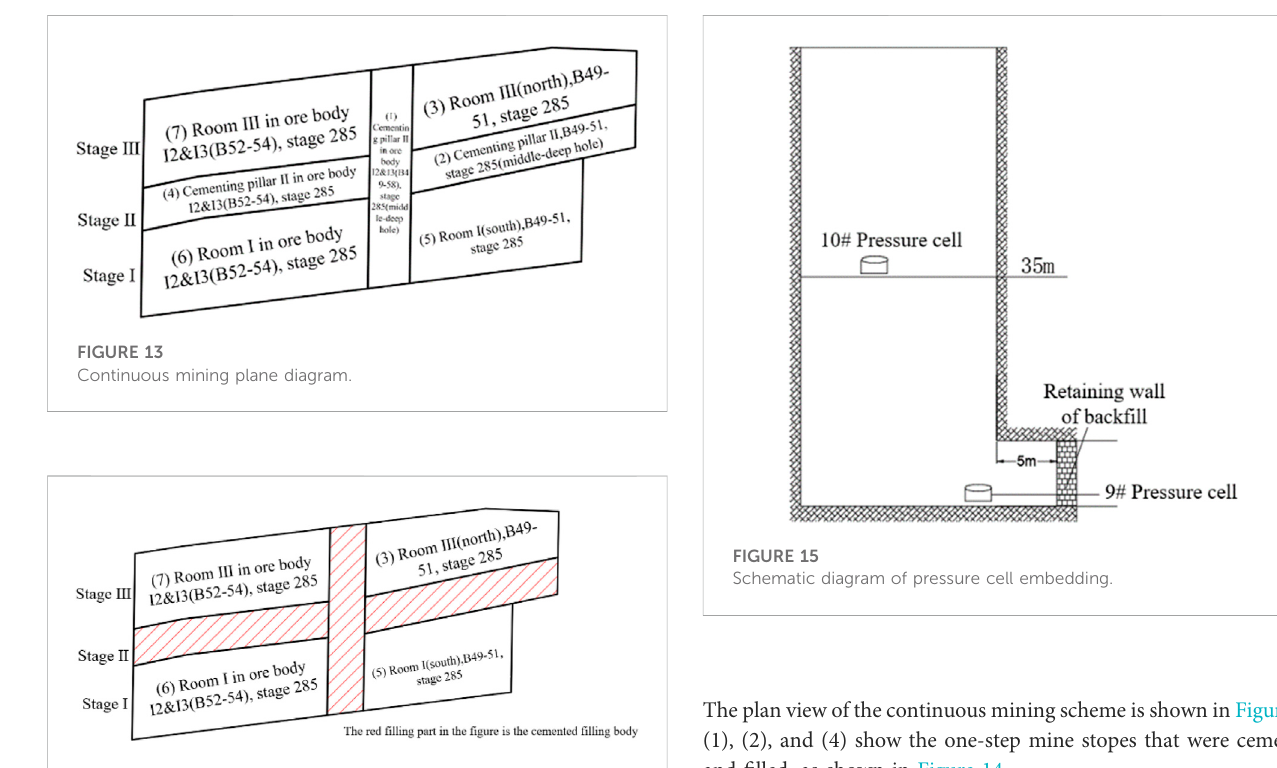
FIGURE 14 One-step stoping and subsequent cemented fi lling.